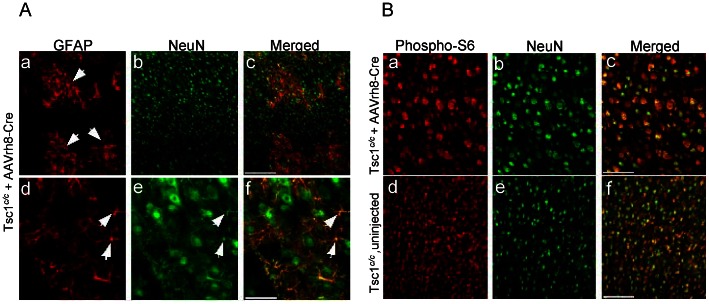
GFAP, NeuN and pS6 staining in brains of AAVrh8-CBA-Cre injected and non-injected Tsc1c/cROSA mice at 1 month.(A) Co-immunostaining for GFAP and NeuN in AAVrh8-CBA-Cre injected Tsc1c/cROSA mice showed clusters of GFAP+ cells in the cortex, some of which co-stained for NeuN (arrows). Scale bars: a–c-:200 µm; d–f: 50 µm. (B) Co-immunostaining for pS6 and NeuN in AAVrh8-CBA-Cre injected Tsc1c/cROSA mice and non-injected mice (a–c) Cells were larger in AAVrh8-CBA-Cre injected mice than in controls and stained more strongly for pS6. Scale bars: a–f: 200 µm.